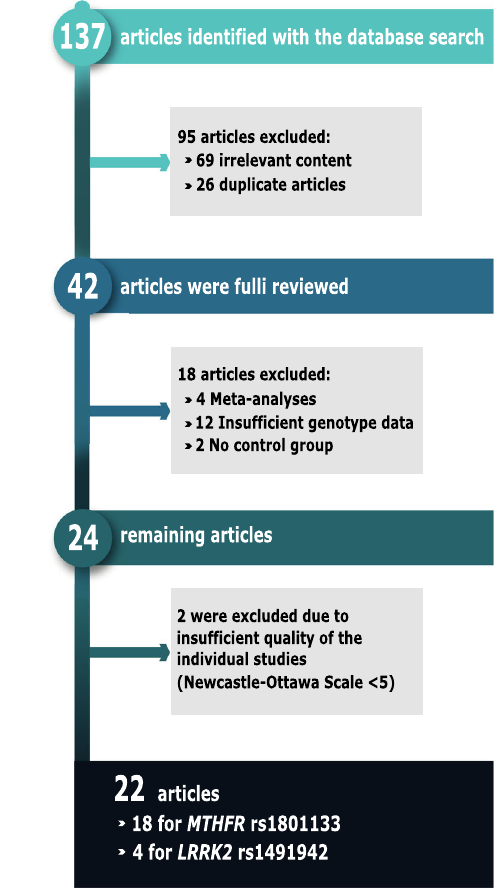
Fig. 2 PD risk association. Flow diagram of the search and inclusion process of studies for the meta-analysis of the SNPs rs1801133 in the MTHFR gene and rs1491942 in the LRRK2